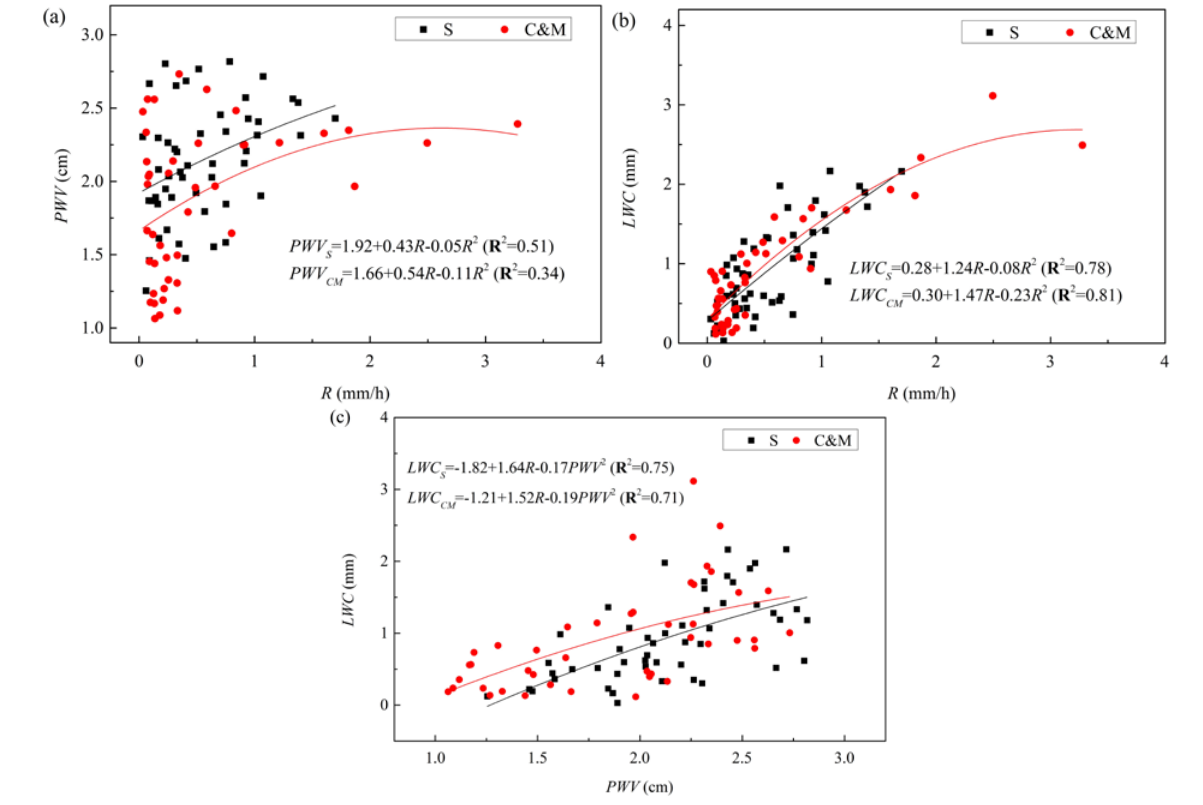
Figure 9. Scattergrams of PWV against R ( a ), LWC against R ( b ), and LWC against PWV ( c ) for stratiform and convective– mixed precipitations. S and C&M denote stratiform and convective–mixed precipitations, respectively.